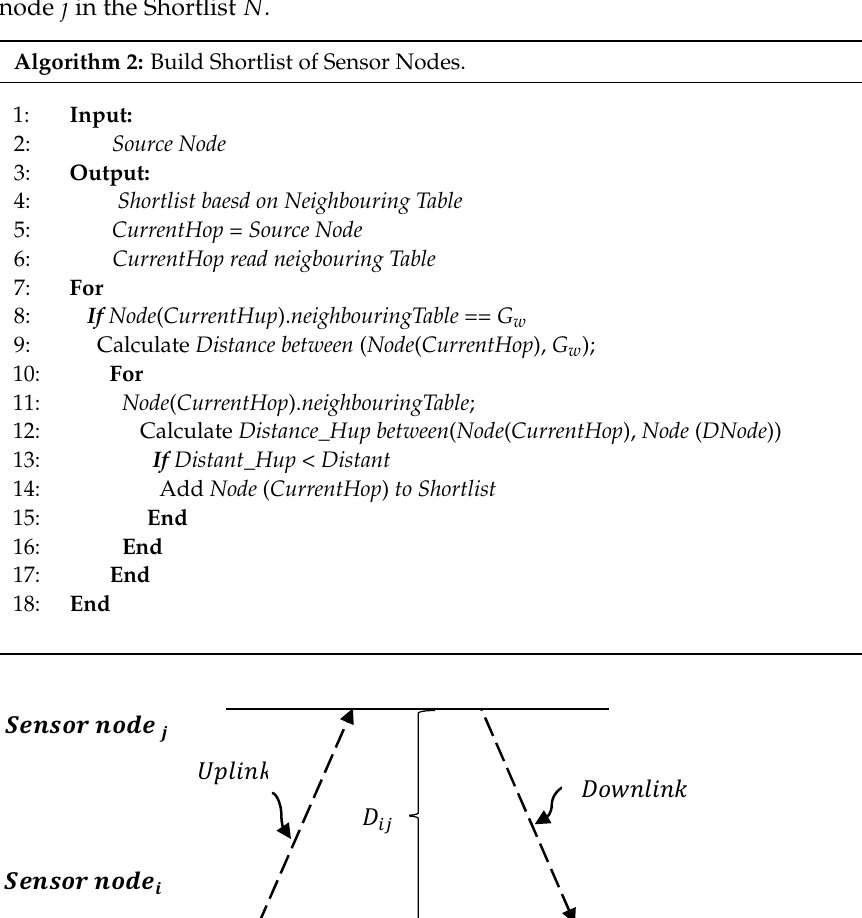
Algorithm 3: Selection Best Path of Graph Routing (BPGR-ES).